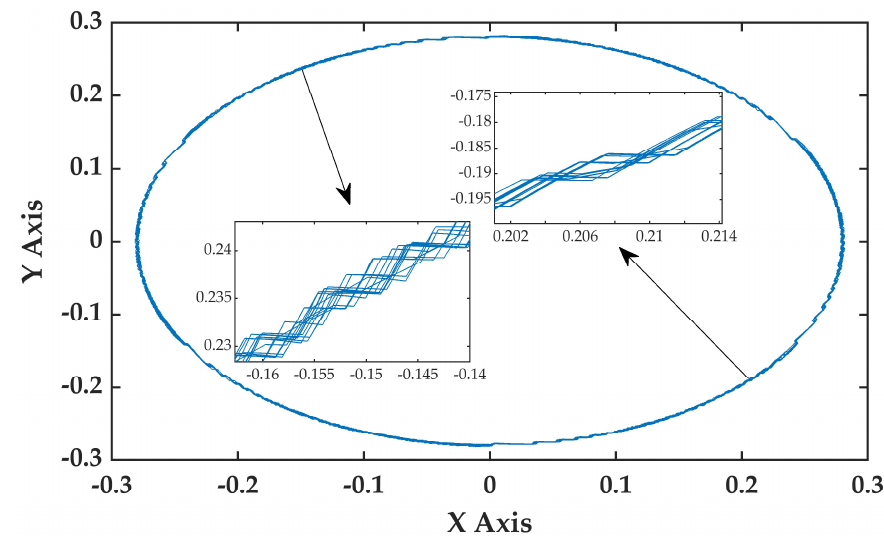
Figure 12. Flux track of the PI controller.